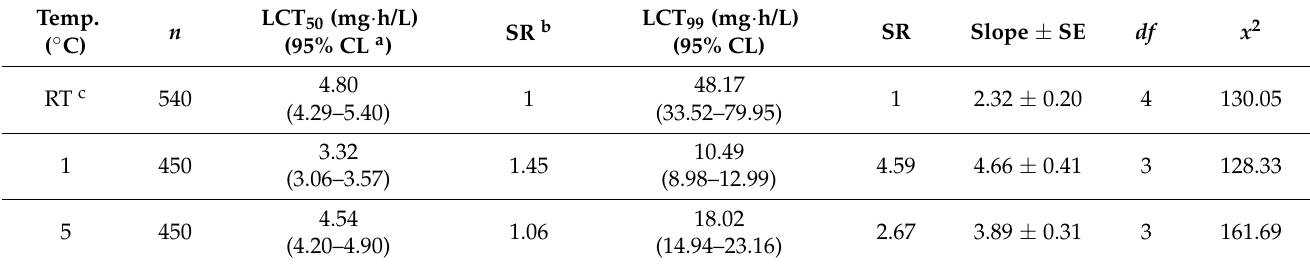
Table 2. Toxicity of the combined treatment in the D. suzukii pupal stage exposed to the two cold- temperature treatments after PH 3 fumigation for 4 h in 12 L